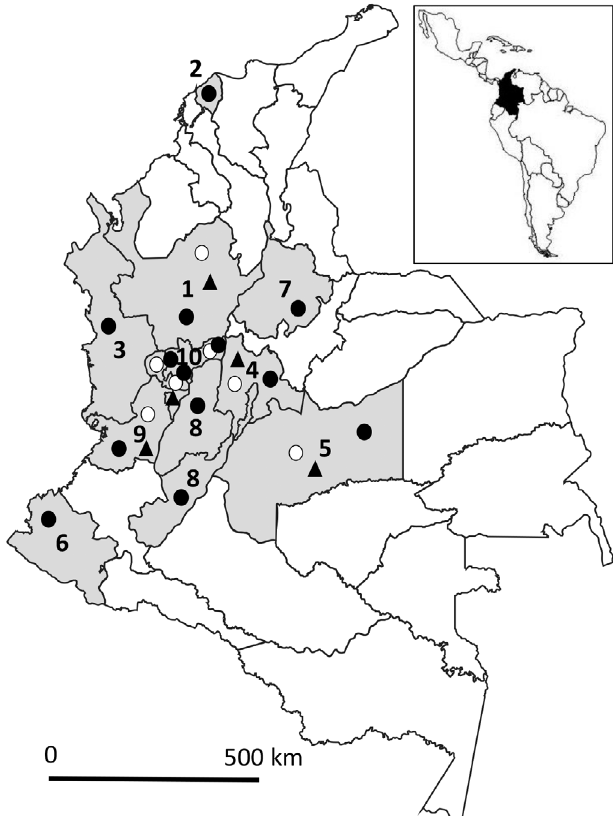
Figure 1. Map of Colombia showing the slaughterhouses where muscle (black circles) and serum samples (open circles) were collected from slaughtered pigs, and pig farms (black triangles) where synanthropic rats were trapped from 2014 to